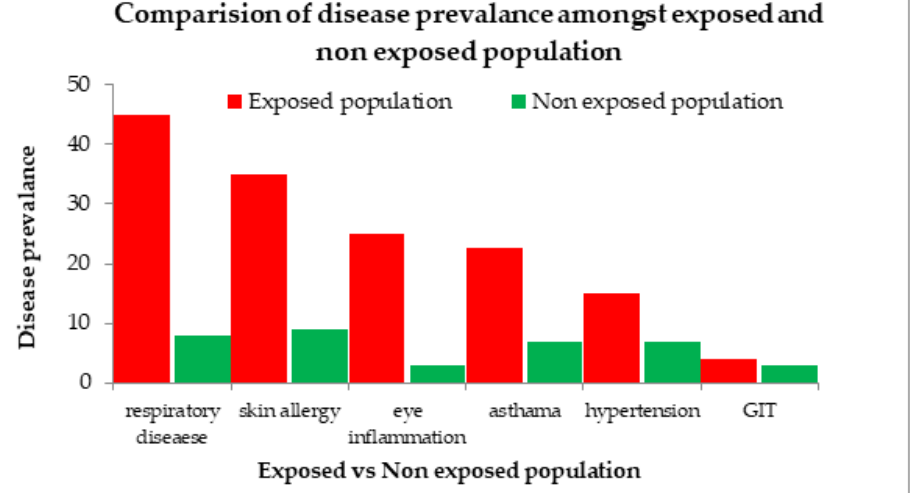
Figure 15. Disease prevalence in exposed and non-exposed population of 3 megacities of Pakistan.